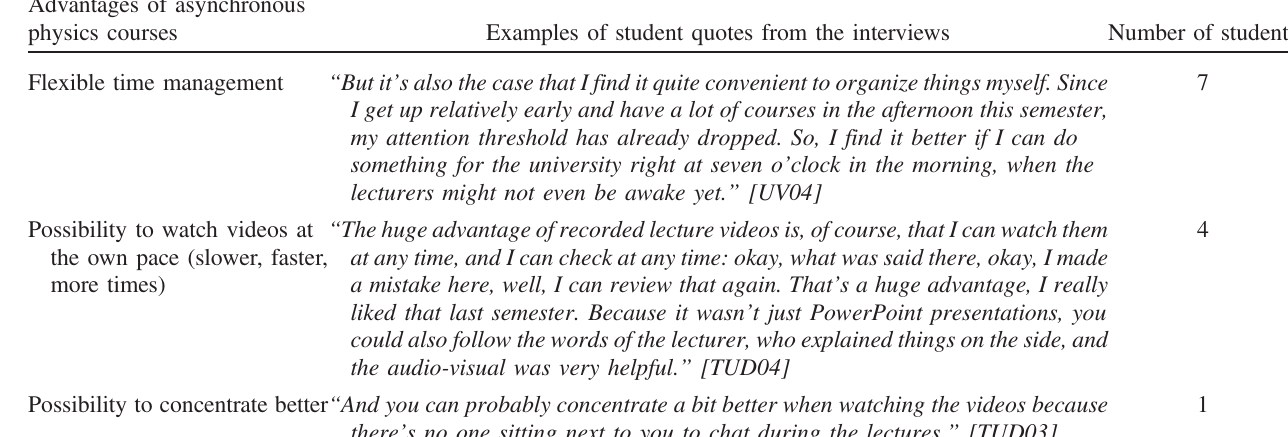
TABLE VI. Advantages and disadvantages of asynchronous physics